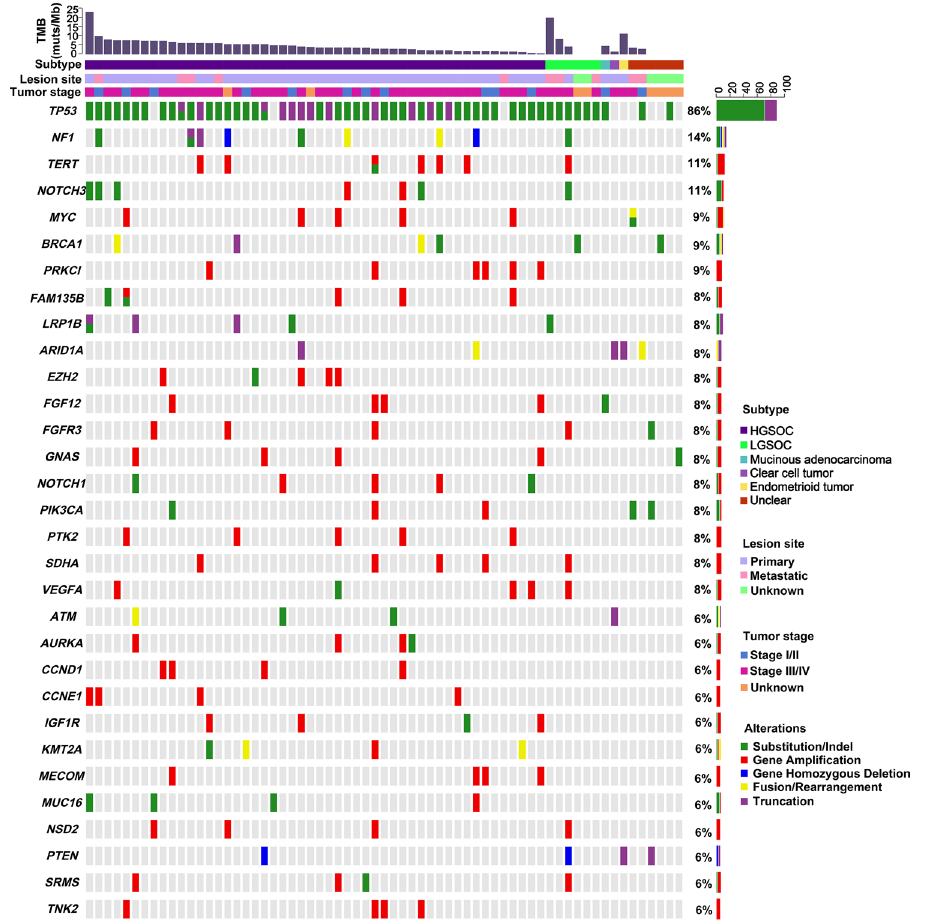
Figure 1. Mutational landscape of 65 ovarian cancer patients. The X-axis represents each case sample and the Y-axis represents each mutated gene. The bar graph above shows the tumor mutational burden (TMB) value of each sample, and the bar graph on the right shows the mutation frequency of each mutated gene in 65 samples. Green represents substitution/Indel mutations, red represents gene amplification mutations, blue represents gene homozygous deletion mutations, yellow represents fusion/rearrangement mutations, and purple represents truncation